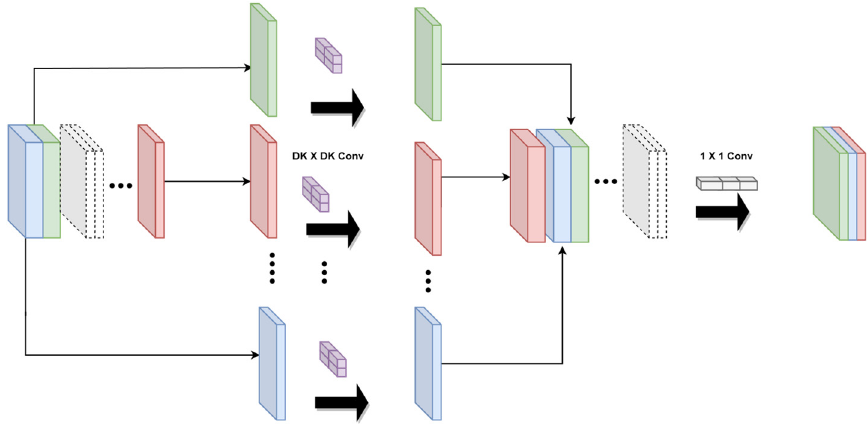
Figure 8. Depth-wise separable convolution.